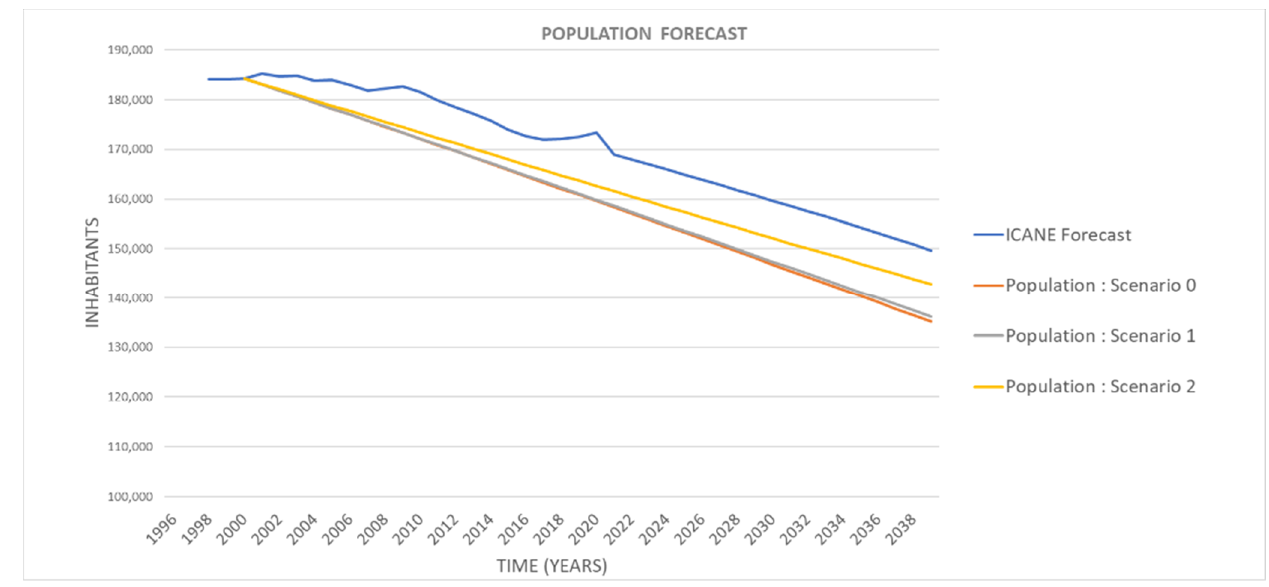
Figure 9. Comparison of the results of the model calibration and the population forecast offered by ICANE [62] (own elaboration).